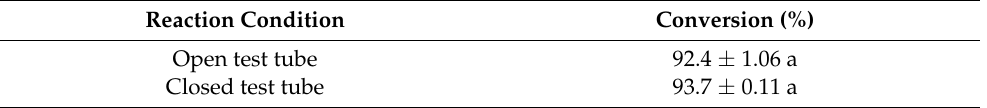
Table 2. Effect of different condition for